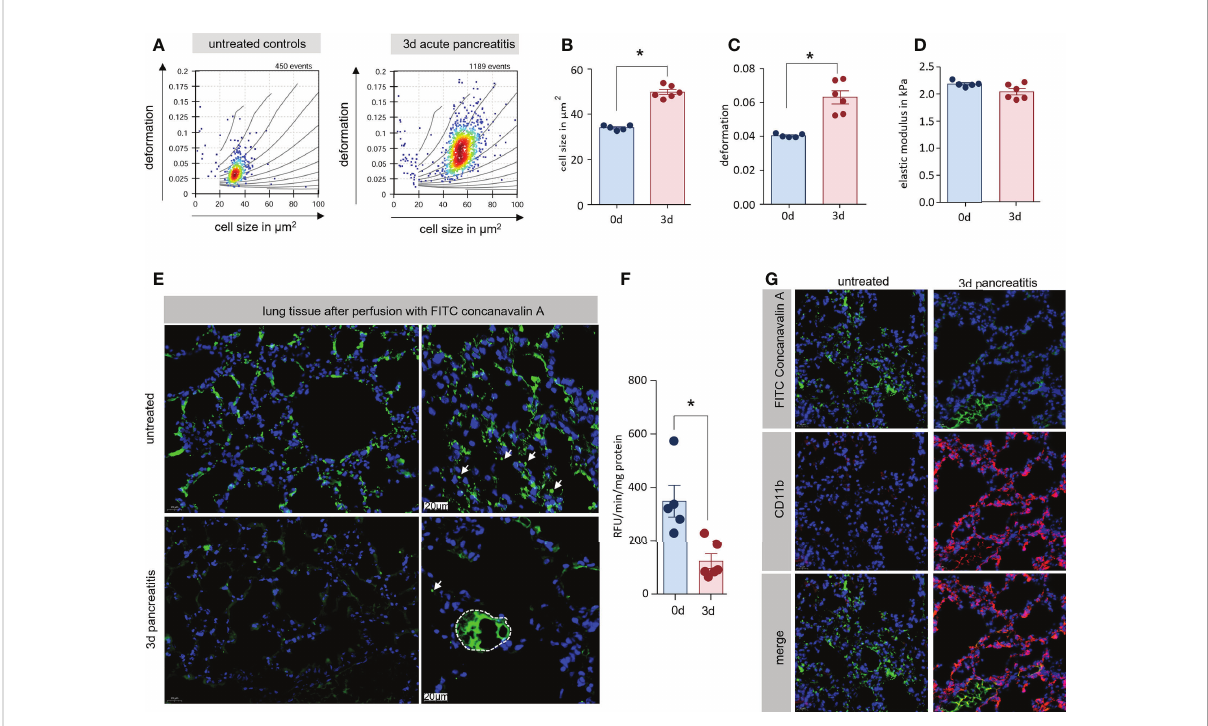
FIGURE 4 Enlarged monocytes were located in lung tissue with reduce microcirculation. (A) Monocytes (re fl ects CD11b + /Ly6g - cells) from lung tissue of mice with and without AP were isolated and analysed by RT-FDC. Deformation vs. cell size scatter plots of monocytes from lung showed the same mechanical characteristics as blood CD11b + /Ly6g - cells (Figure 4). (B, C) Statistical analysis of experimental replicates indicates a signi fi cant increase in cell size and deformation. (D) No signi fi cant change in elastic modulus is observed. (E) To visualise the blood circulation in the lungs, the animals were perfused with fl uorescein conjugated concanavalin a. 3d after induction of AP, only large vesicles could be stained with concanavalin a. (F) Quanti fi cation of fl uorescence in lung tissue homogenate showed a signi fi cant reduction 3d after onset of